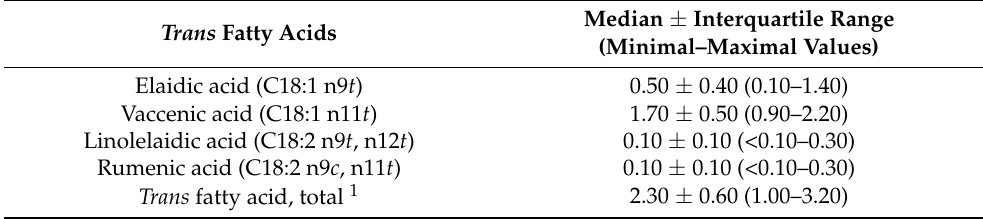
Table 4. Trans fatty acid level (% of total fatty acids) in human milk.